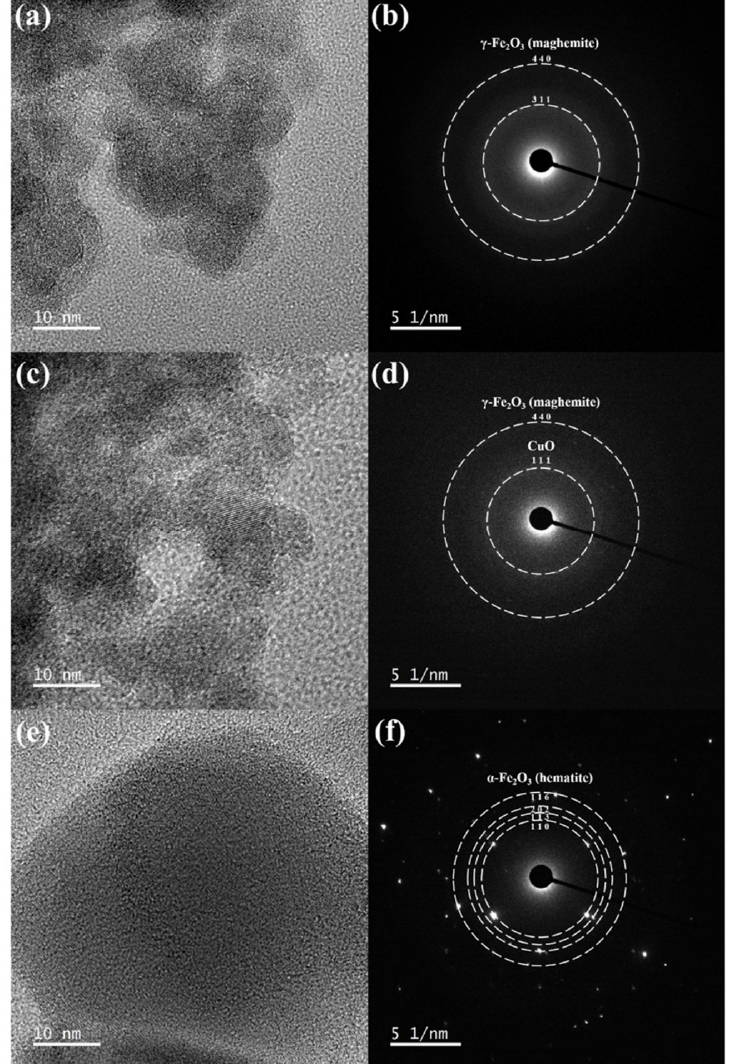
Figure 1. TEM images and SAED patterns of fresh FAC-PC-3, FAC-PC-3-240, and Fe-Al catalysts: ( a ) and ( b ) FAC-PC-3, ( c ) and ( d ) FAC-PC-3-240, ( e ) and ( f ) SAED Fe-Al. Adapted from Ref. [28]. ( a , b ) FAC-PC-3, ( c , d ) FAC-PC-3-240, ( e , f ) SAED Fe-Al. Adapted from Ref. [28]. Copyright 2019